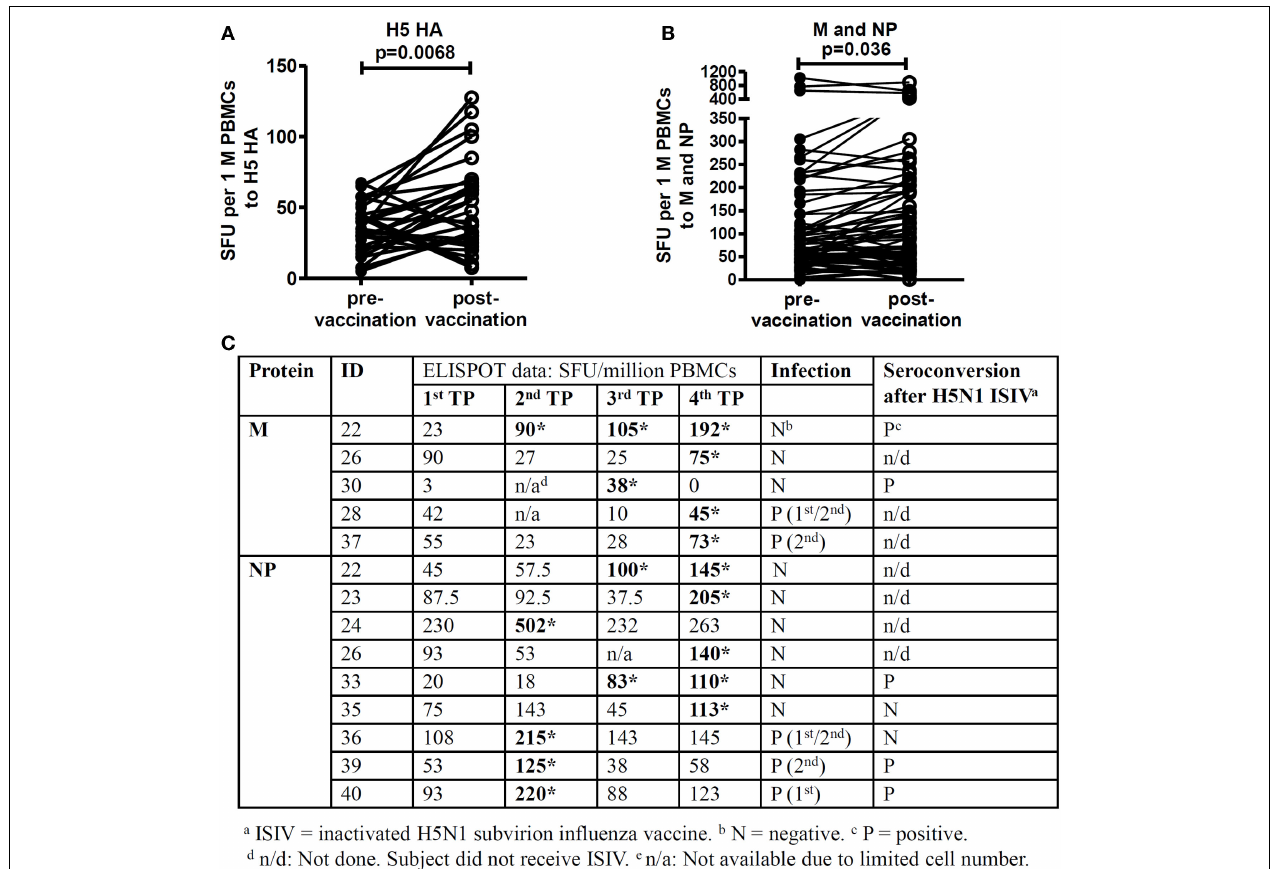
FIGURE 2 | Elevated T cell responses after each vaccination . T cell responses at all four time points (TP) were screened by ex vivo IFN- γ ELISPOT using overlapping peptides fromH1 HA, H3 HA, H5 HA, and H5N1 VN 2004 Matrix proteins (M1 and M2) and Nucleoprotein. n = 2 replicates. (A) Comparison of T cell responses targeting H5 HA peptides pre- and post-